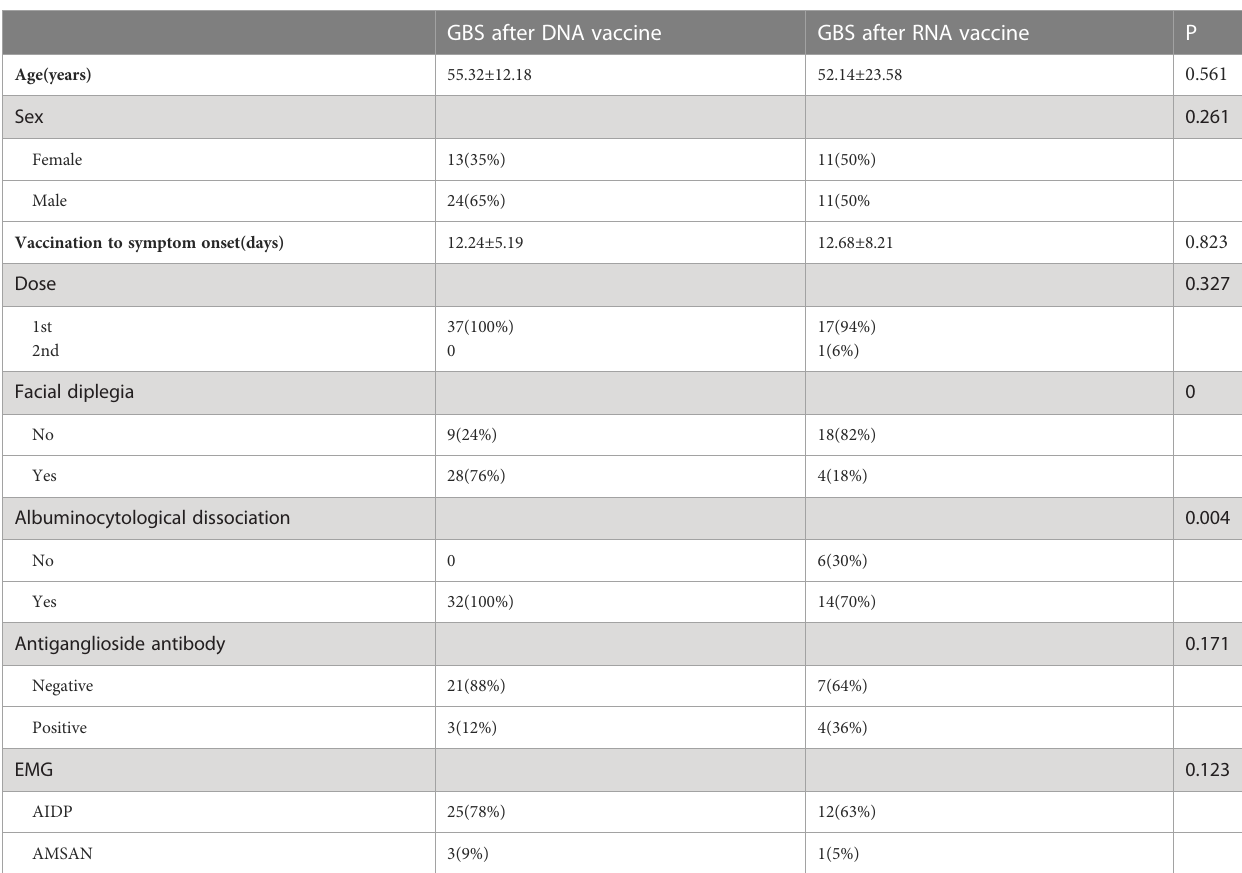
TABLE 2 Comparison of GBS between the DNA and RNA vaccine groups. GBS after DNA vaccine GBS after RNA